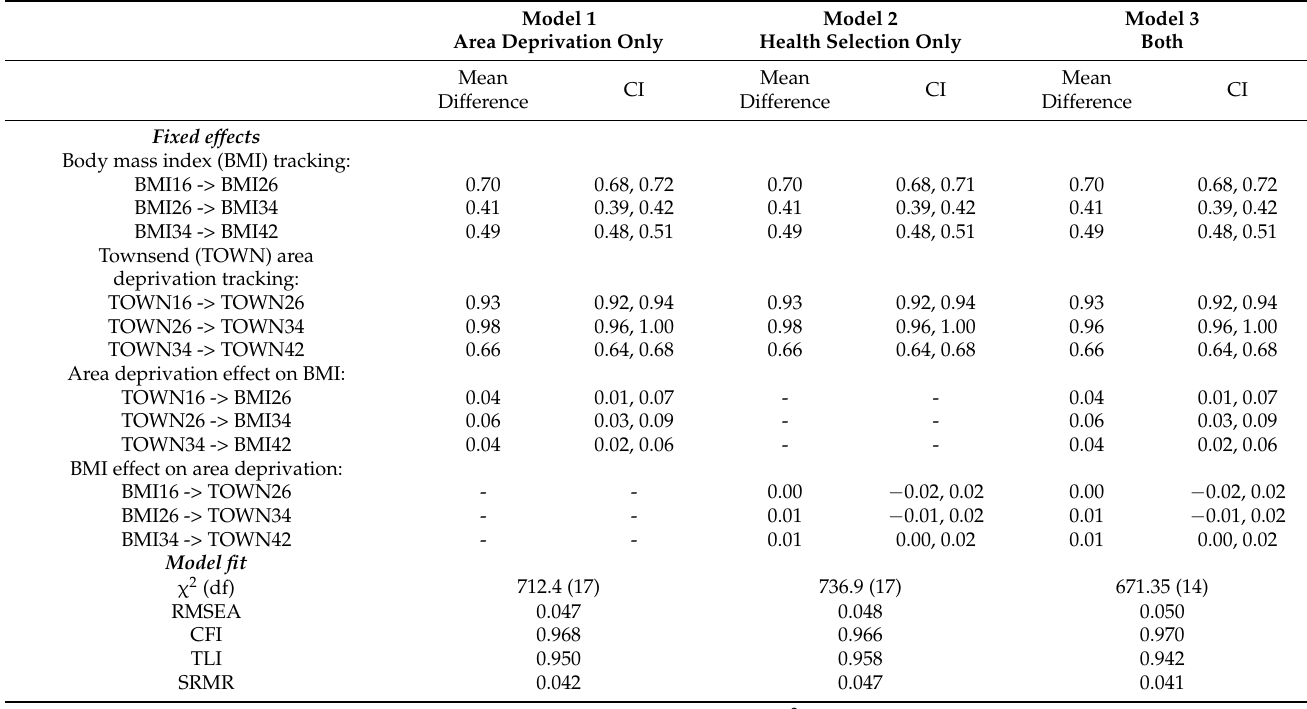
Table 2. Direct effects modelled using structural equation modelling and multiple imputation (1970 cohort, n = 18,639).